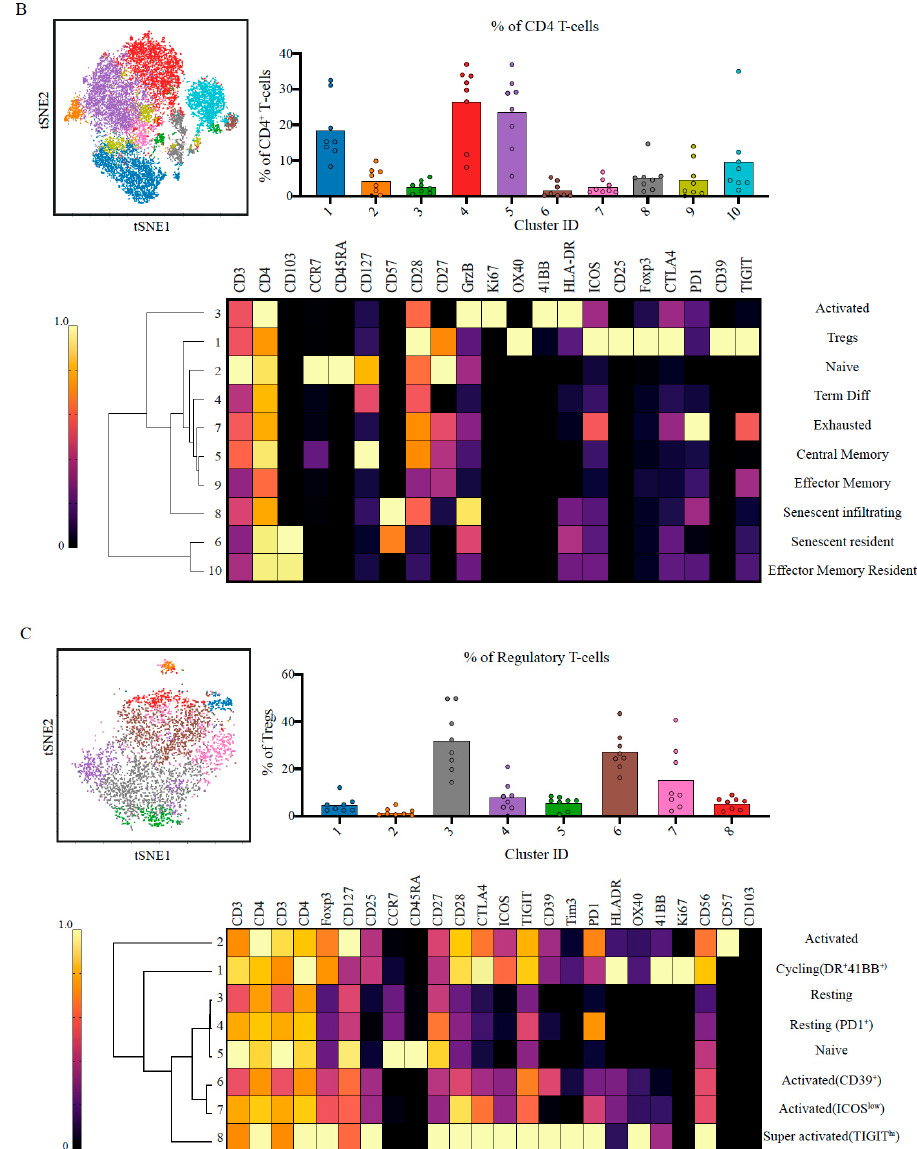
Figure 2. CD8 + T-cell senescence and activated Tregs dominate the landscape of the tumour. ( A ) ~14,750 CD8 + T-cells were pooled and 14 metaclusters identified with FlowSOM and visualised on viSNE plot. Metaclusters’ relative abundance is shown in the bar plot MC1,2 are plotted on the left y -axis, MC3-14 are plotted on the right y -axis. The heatmaps show the expression profile of immune checkpoints in the different metaclusters and identified unique populations based on the combinatorial expression. Note that the major CD8 + populations are effector memory cells and the presence of 4 metaclusters corresponding to senescent cells. There is also a proportion of exhausted cells as well as metaclusters of activated cells. ( B ) ~17,870 CD4 + T-cells were pooled and 10 metaclusters identified with FlowSOM and visualised on viSNE plot. Metaclusters’ relative abundance is shown in the bar plot. The heatmaps show the expression profile of immune checkpoints in the different metaclusters and identified unique populations based on the combinatorial expression. The major populations are central memory cells, and there were 5 metaclusters identified as regulatory T-cell (analysed in depth in ( C )). ( C ) ~3900 CD4 + regulatory T-cells were pooled and 8 metaclusters identified with FlowSOM and visualised on a viSNE plot. Metaclusters’ relative abundance is shown in the bar plot. The heatmaps show the expression profile of immune checkpoints in the different metaclusters and identified unique populations based on the combinatorial expression. More than 50% of the metaclusters show an activated phenotype albeit at different magnitudes. The subpopulations are annotated based on the combination of checkpoints and their level of expression. All bar plots are median and the individual dots are individual patients. Heatmaps are normalised for each marker with lowest expression marked in dark blue as zero, and highest in yellow as 1. Hierarchal clustering of heatmaps was done in